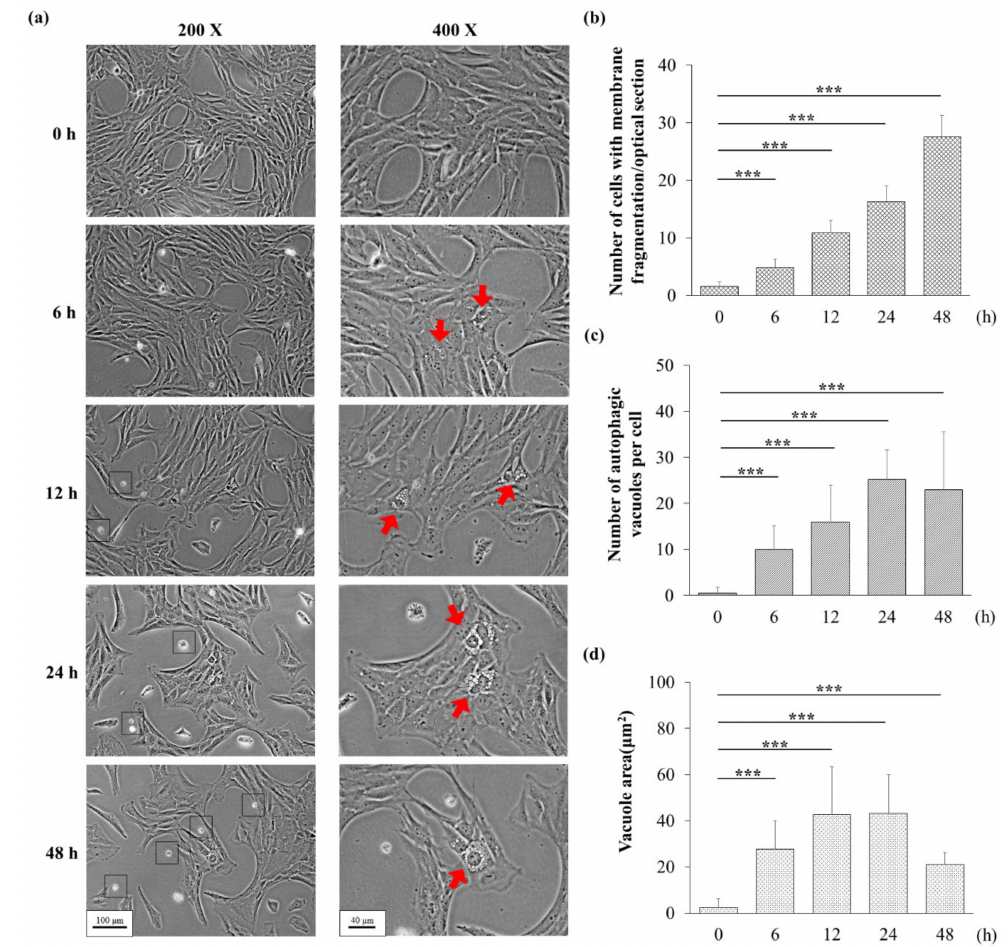
Figure 3. E ff ects of H 2 O 2 in mouse cochlear UB / OC-2 cells. ( a ) The cells were treated with 75 µ M H 2 O 2 for 24 and 48 h, and images were obtained at the end of the incubation period using a visible light microscope (black bar: magnification of 200 X = 100 µ m and magnification of 400 X = 40 µ m). Squares indicate membrane fragmentation and red arrows indicate cytoplasmic vacuoles. ( b ) The number of cells with membrane fragmentation was counted in six randomly optical sections. ( c ) The number of autophagic vacuoles per cell was analyzed from at least 10 randomly chosen fields. ( d ) The area of autophagic vacuole was analyzed from at least 10 randomly chosen cells. For panels ( b – d ), * p < 0.05, ** p < 0.01, and *** p < 0.001 indicate significant di ff erences from the control